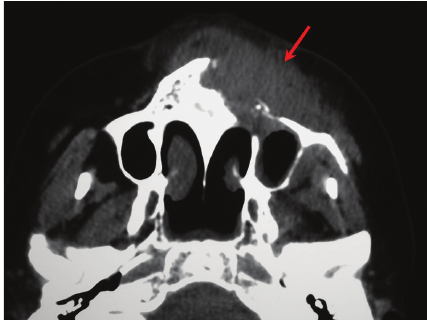
Figure 2: Axial CT image showing an infiltrative mass in the left maxillary region with destruction of the maxillary bone anteriorly wall, invading